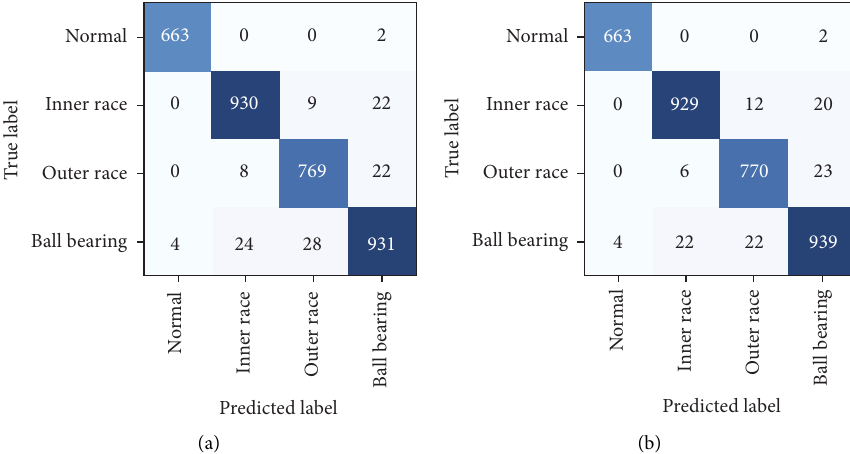
Figure 7: Confusion matrices for Exp. 4 using PART+multiboost on the test dataset (a) with T30 and (b) with T30 ∗ .